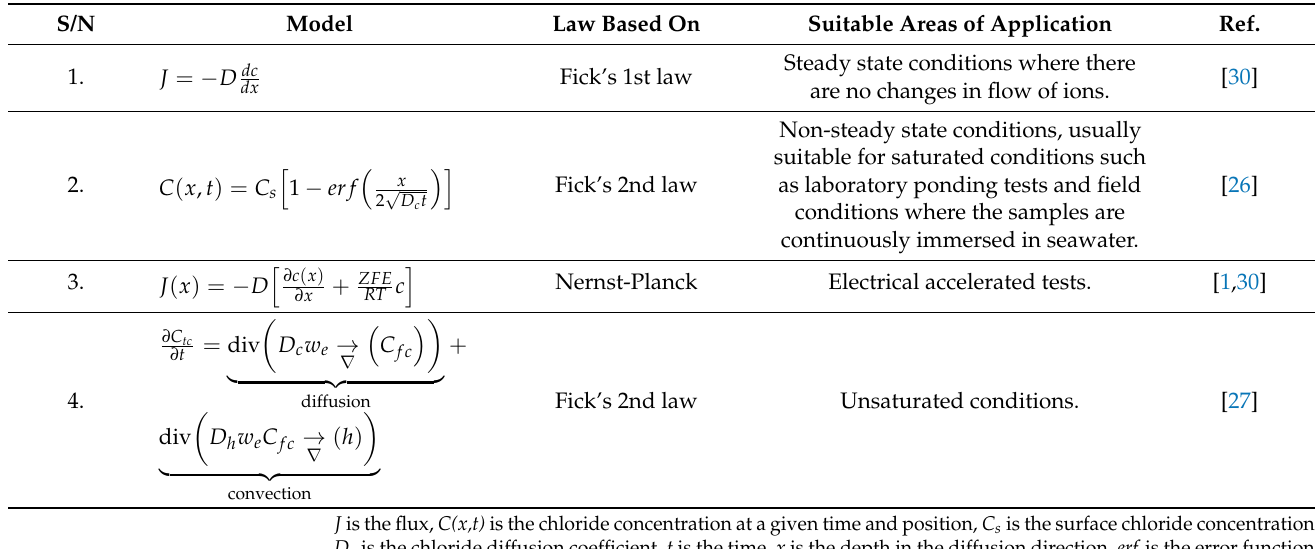
Table 1. Typical chloride diffusion models used in chloride ingress studies.